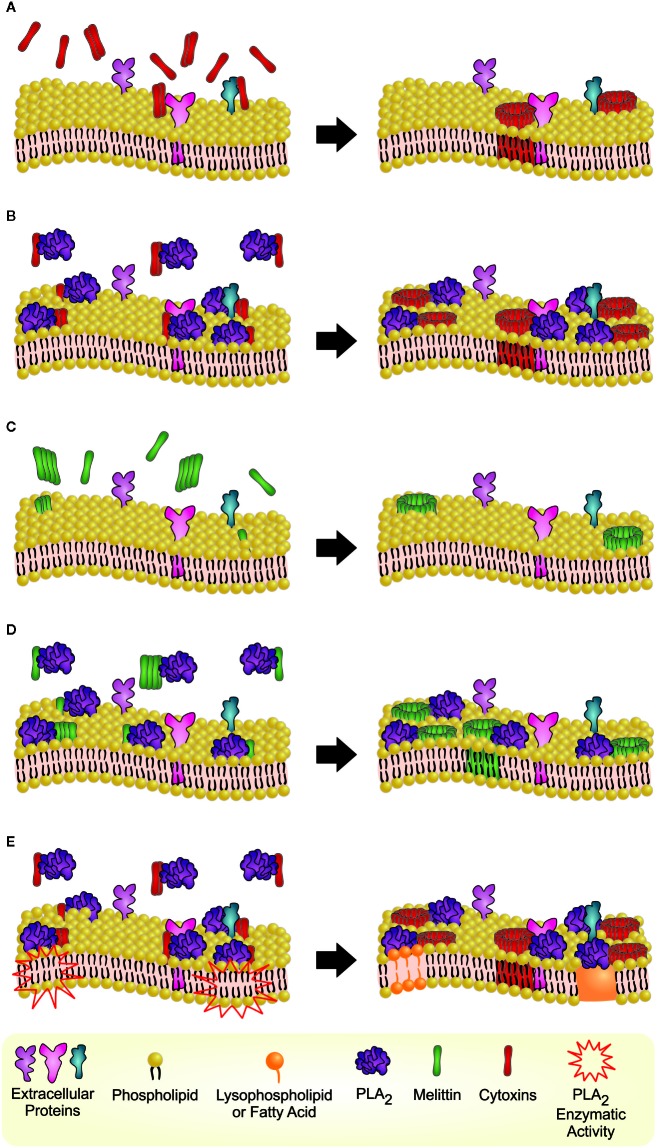
Hypothetical phenomena of synergistically enhanced cell lysis mediated by cytotoxin-PLA2 or melittin-PLA2 hetero-oligomers on phospholipid bilayer membranes. (A) Cytotoxins (monomers or oligomers) likely bind to anionic extracellular proteins or carbohydrates (Harvey, 2018), which may lead to further oligomerization and formation of membrane pores, leading to cell lysis (Forouhar et al., 2003; Konshina et al., 2011). (B) When combined with PLA2s, cytotoxins are more likely to easily bind to the neutral outer membrane on the lipid binding surface of the molecule (Singer et al., 2002; Burke and Dennis, 2009), resulting in synergistically enhanced lysis. (C) Different to cytotoxins, which are proteins of predominantly beta sheet structure, the helical structure of melittin provides better opportunities for melittin interaction with neutral membranes (Dempsey, 1990; Kleinschmidt et al., 1997), which is possibly mediated via electrostatic attraction between basic amino acid residues of melittin and the phosphate group of phosphatidylcholine (Dempsey, 1990; Kleinschmidt et al., 1997). The melittin-phospholipid binding enables melittin oligomerization, formation of membrane pores, and lysis (Yang et al., 2001; Pucca et al., 2019). (D) As for cytotoxins, PLA2s can also facilitate melittin binding in the cell membrane, resulting in synergistically enhanced lysis. (E) PLA2-induced hydrolysis also affects membrane integrity through the detergent action of the hydrolytic products of phospholipids, which may also contribute to the lytic effects (Lomonte and Gutiérrez, 2011). The last hypothetical phenomenon is unlikely to account for the synergistic effects observed for MII, since this toxin lacks enzymatic activity.